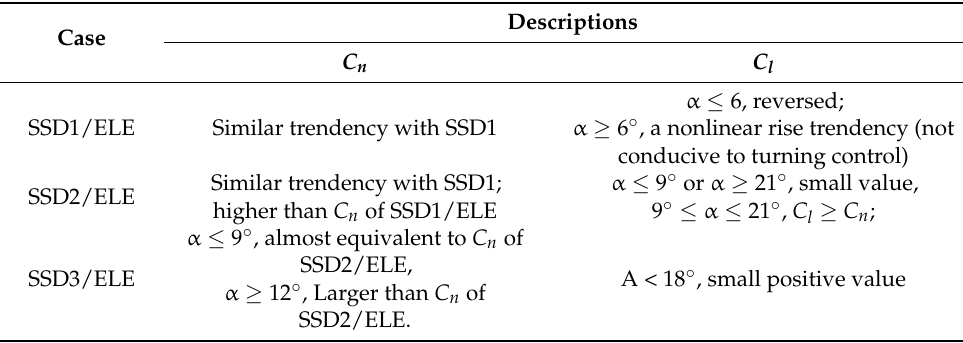
Table 7. Descriptions of control characteristics for the three